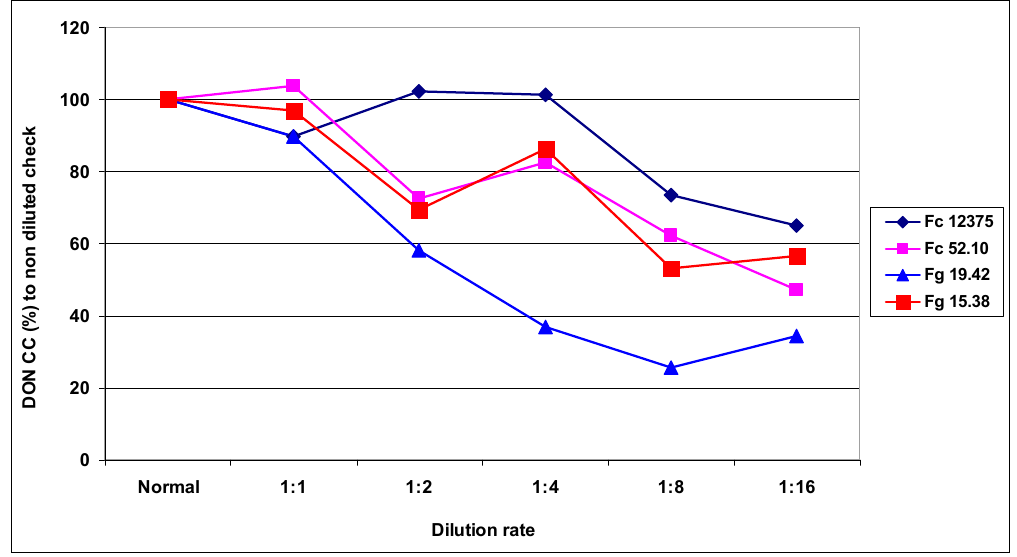
Figure 6. Reduction of the aggressiveness of F. graminearum and F. culmorum isolated at different dilution rates, DON data related to the non-diluted original inoculum, 2013 and 2014.